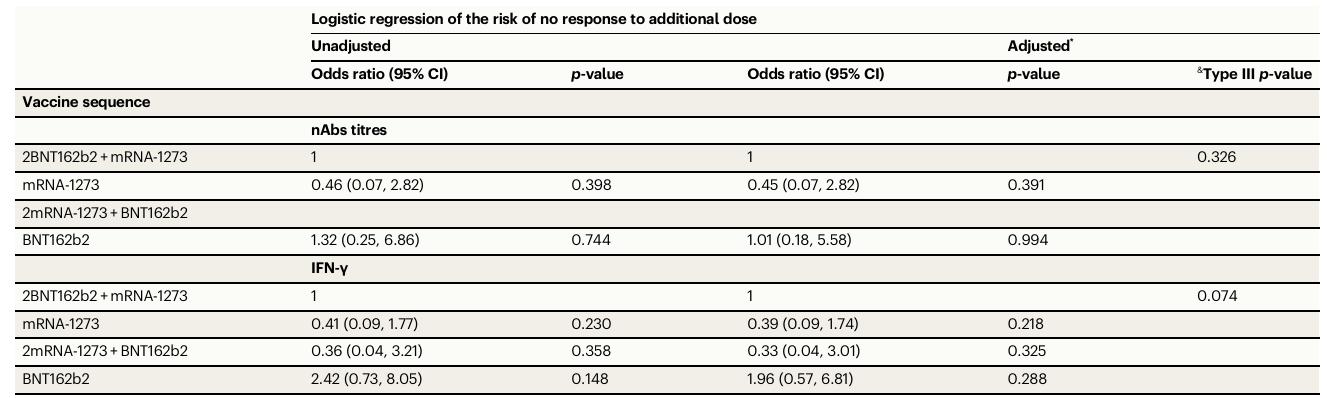
Table 5 | Vax sequence model - OR of non response from fi tting a logistic regression analysis Logisticregression ofthe risk ofno responsetoadditional